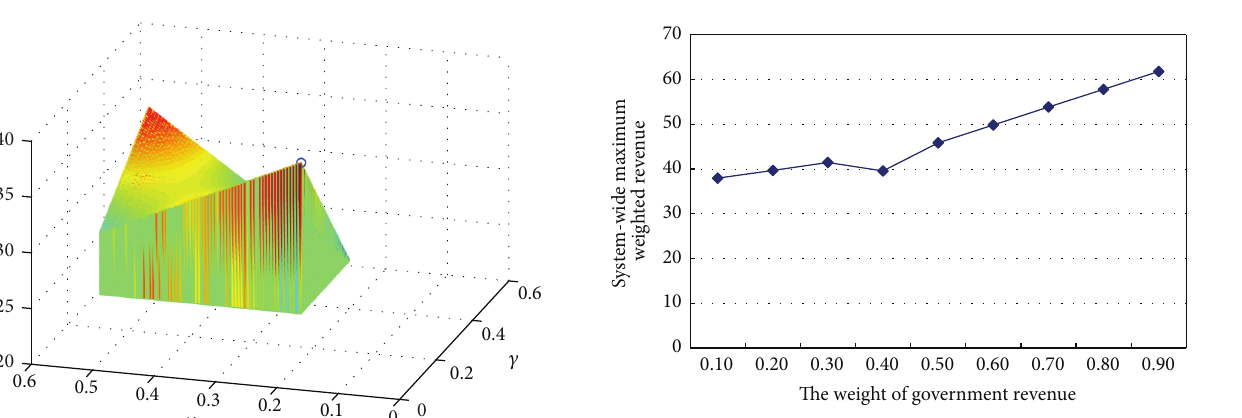
Figure 1: When 𝛼 = 0.1 , 𝛽 = 0.9 , The weighted three-dimensional map system-wide revenue.